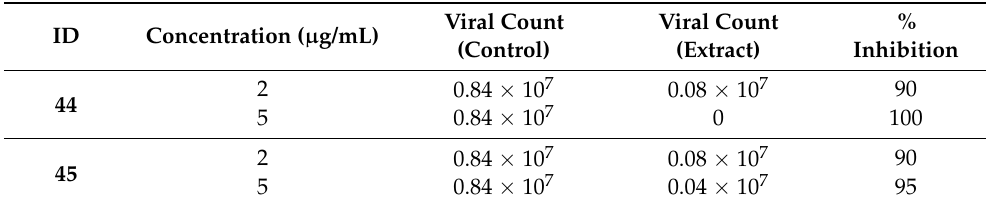
Table 6. The calculated percentage of inhibition in the plaque reduction assay of compounds 44 and 45 [42].